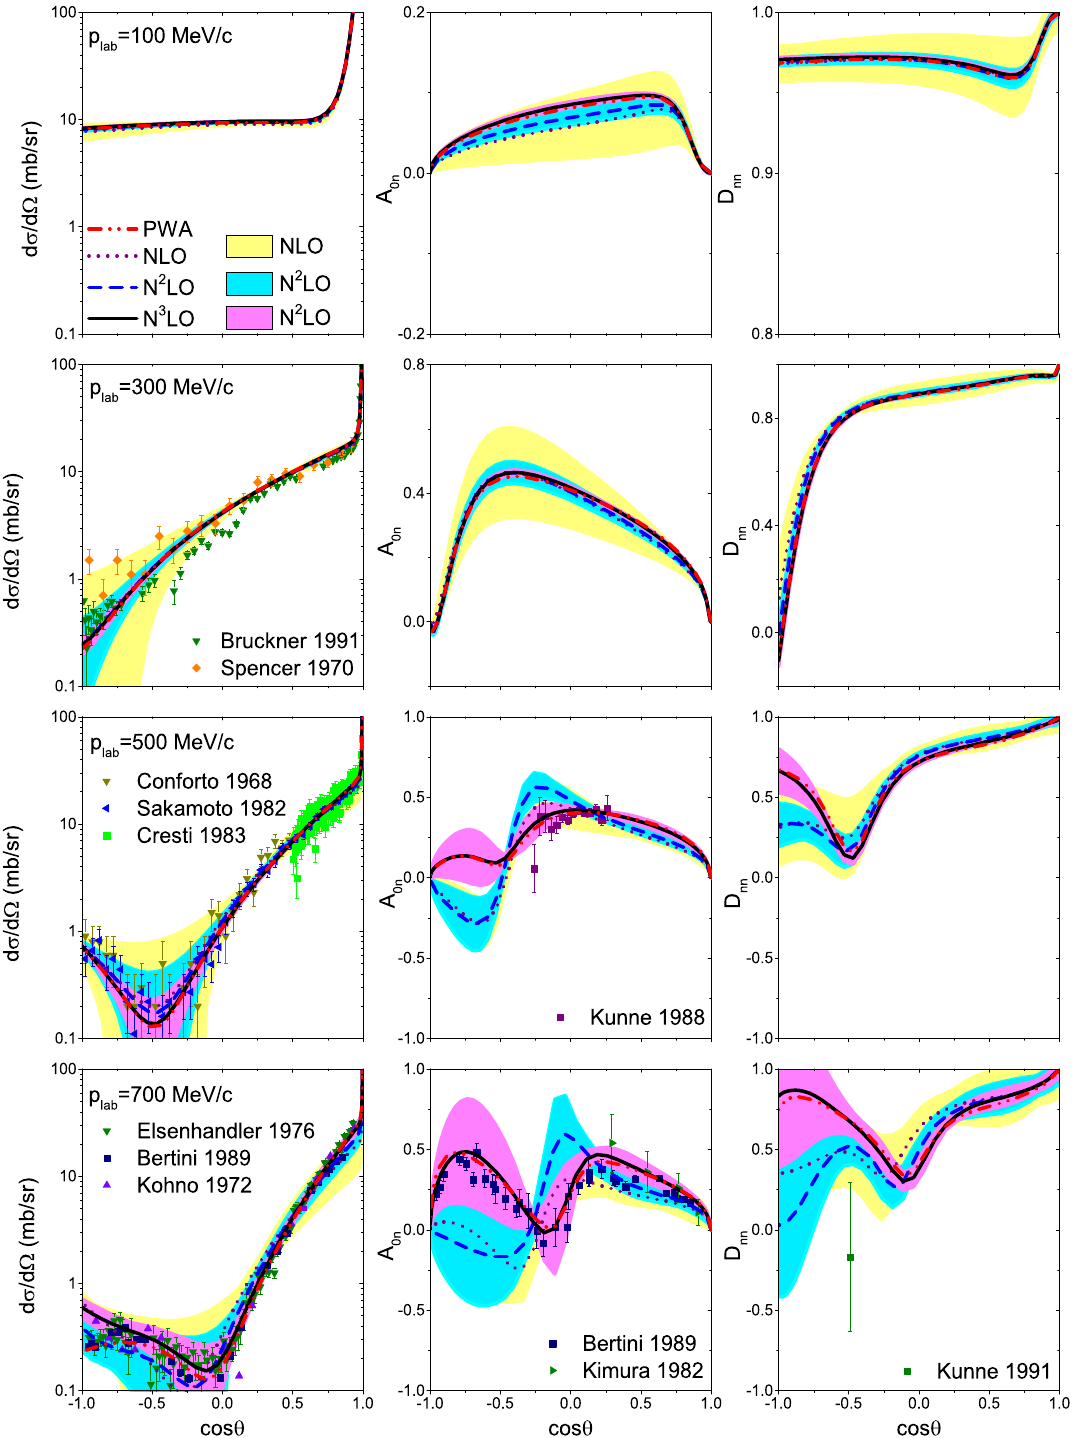
Figure 10 . Di(cid:11)erential cross sections, analyzing powers and spin correlation parameters D nn for (cid:22) pp elastic scattering. Notations are described in the text. The red/dash-double dotted line represents the result of the PWA [32]. Data are taken from refs. [74, 80, 82{87] (di(cid:11)erential cross sections), [86, 88, 89] (analyzing powers), and [90] ( D nn ).